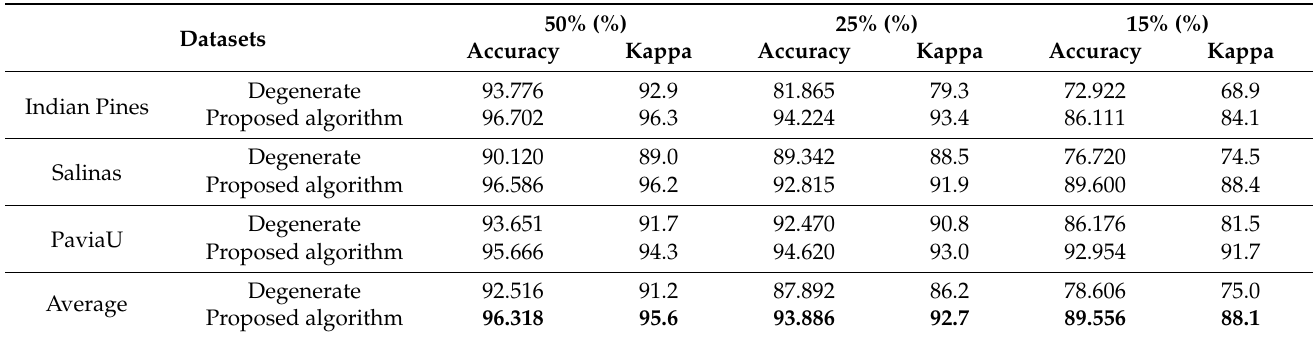
Table 3. The classification results on different dividing ratios of three public datasets.